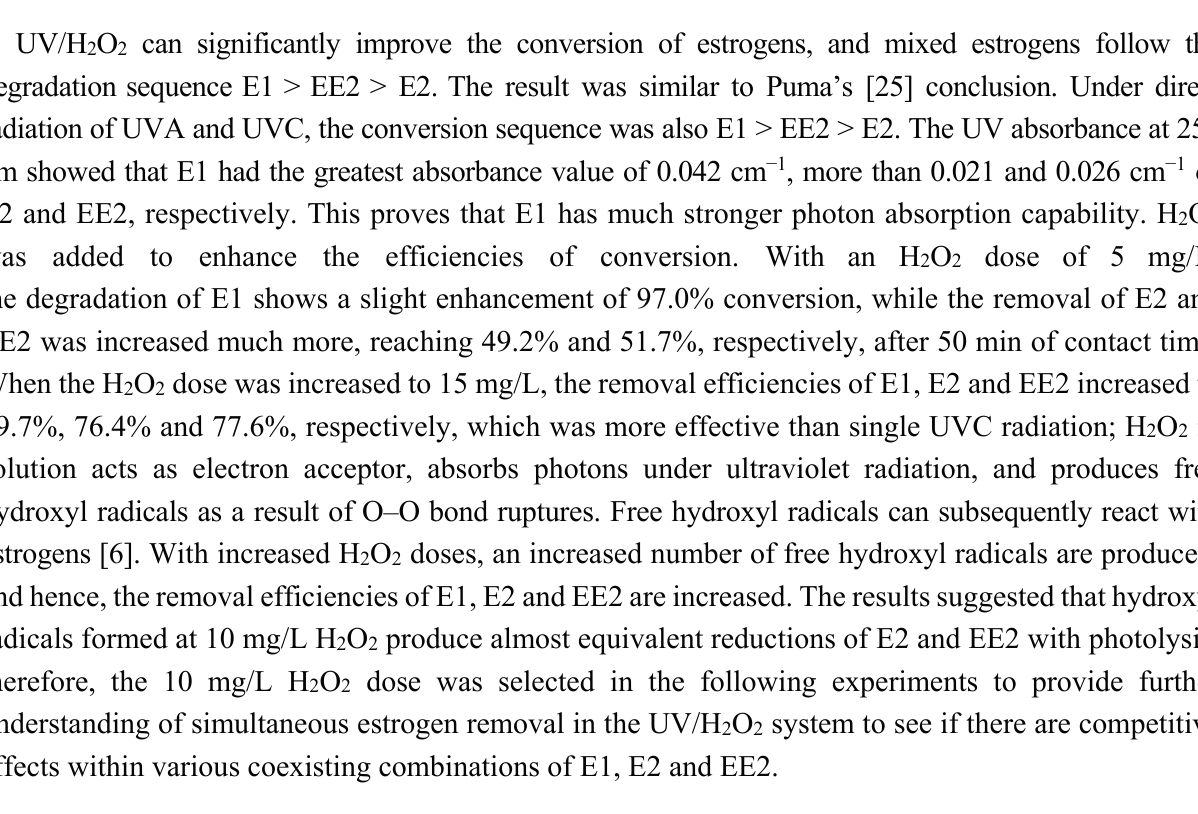
Figure 1. Degradation kinetics of mixed pollution estrone (E1), 17 β -estradiol (E2) and 17 α -ethinyl estradiol (EE2) under UVC and UV/H 2 O 2